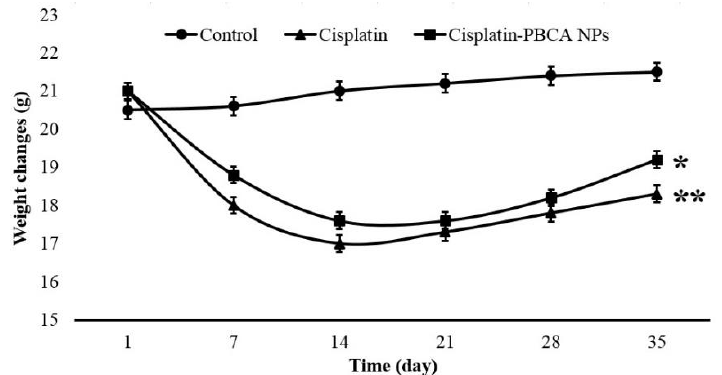
Figure 6. The weight changes in the lung-cancer-bearing mice treated with cisplatin and the nanodrug compared to the control group. The results are expressed as mean ± 5% of the values obtained from monitored mice in each group.